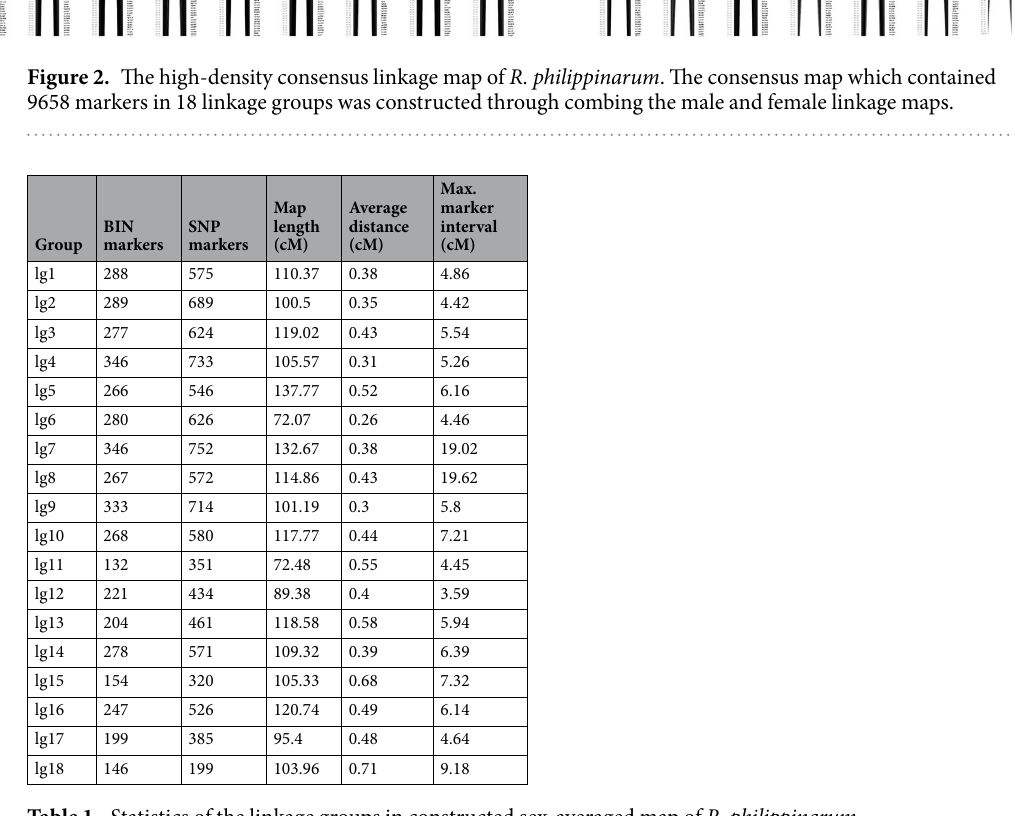
Table 1. Statistics of the linkage groups in constructed sex-averaged map of R. philippinarum